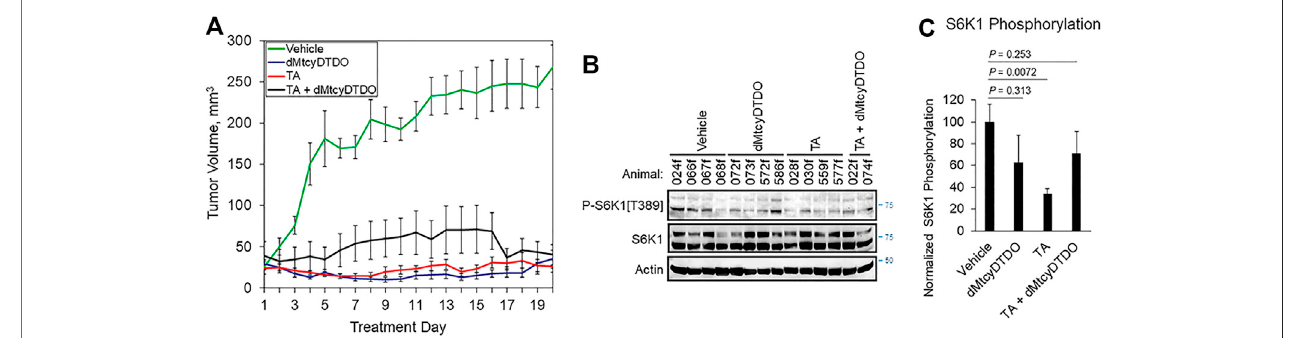
FIGURE 4 | TA blockade of breast tumor growth is associated with reduced S6K1 phosphorylation. (A) Growth curves of 012/LVM2/LR10 tumors treated once daily by oral gavage with vehicle (peanut oil), 10 mg/kg dMtcyDTDO, 375 mg/kg TA or combined treatment with the 10 mg/kg dMtcyDTDO and 375 mg/kg TA. Results are the average obtained from 10 animals in each treatment group and presented as the average ± S.D. (B) Immunoblot analysis of tumor extracts with the indicated antibodies. (C) Plot of S6K1 phosphorylation normalized to S6K1 protein levels. Results represent the average of four samples from each treatment group. Error bars represent S.E.M. Pairwise statistical comparisons between the vehicle and drug treatment groups were made using unpaired Student ’ s t